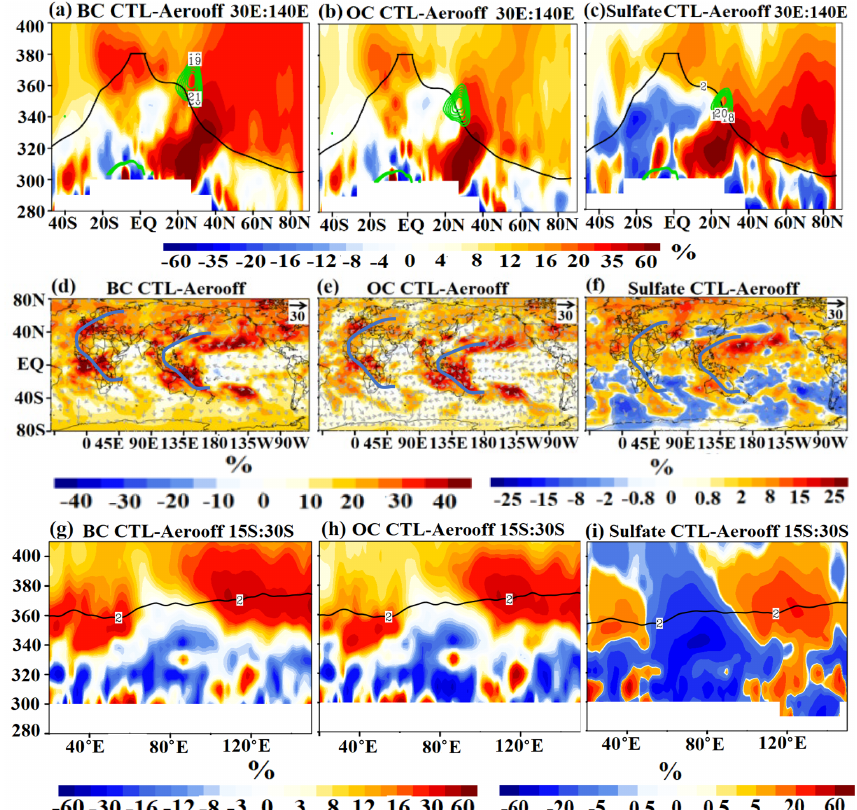
Figure 4. Meridional cross-section over Indian Ocean–western Pacific (averaged 30–140 ◦ E and for the spring season for the years 2001– 2016) of anomalies (%) (CTL-Aerooff) of (a–c) BC, OC, and sulfate aerosols. Green contours in (a–c) indicate westerly jet. (d–f) Spatial distribution of BC, OC, and sulfate aerosols averaged at 360–390K isentropic levels and the spring season for the years 2001–2016. Vectors in (d–f) indicate anomalies of winds (ms − 1 ). (g–i) Zonal cross-section (averaged over 15–30 ◦ S and for the spring season for the years 2001–2016) and for the spring season for BC, OC, and sulfate aerosols. The black line of 2PV (in a–c and g–i ) indicates the dynamical